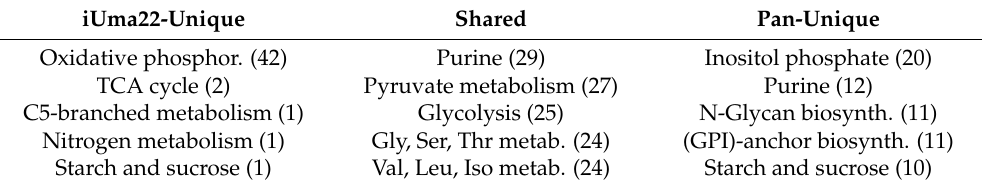
Figure 4. Comparison of enzymes in U. maydis strain pangenome and iUma22. ( A ) E.C.-annotated genes in strain 512 that are unique to 512 or shared with the other strains. ( B ) Coverage of the genes in iUma22 of E.C.-annotated genes in the pangenome identified by KAAS. Table 4 show the top five pathways with the most association for iUma22-unique, pangenome-unique, and their intersection. ( C ) The inositol phosphate metabolism contains 20 genes with the highest level of missing genes in iUma22 (Supplements). Table 4. Top five metabolic pathways with the highest number of missing genes in iUma22 compared to the strain pangenome. The annotation is based on KAAS, considering only KEGG pathways (KAAS outputs for iUma22-unique, -shared, and pangenome-unique provided as Supplementary